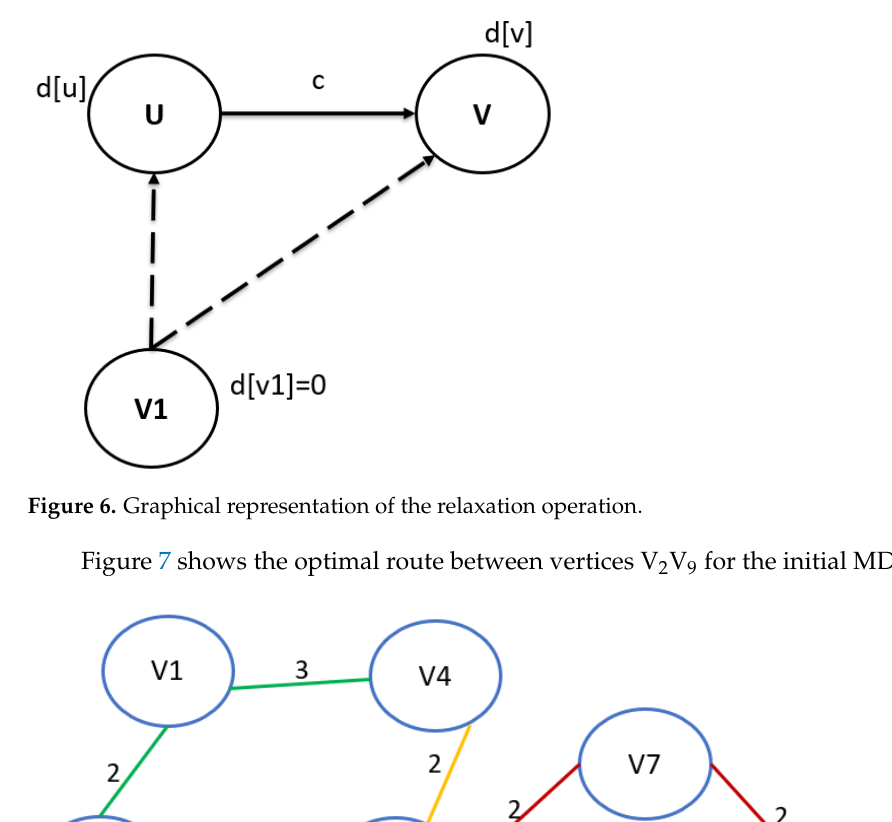
Figure 7. Optimal route in a multilayer data transmission network .